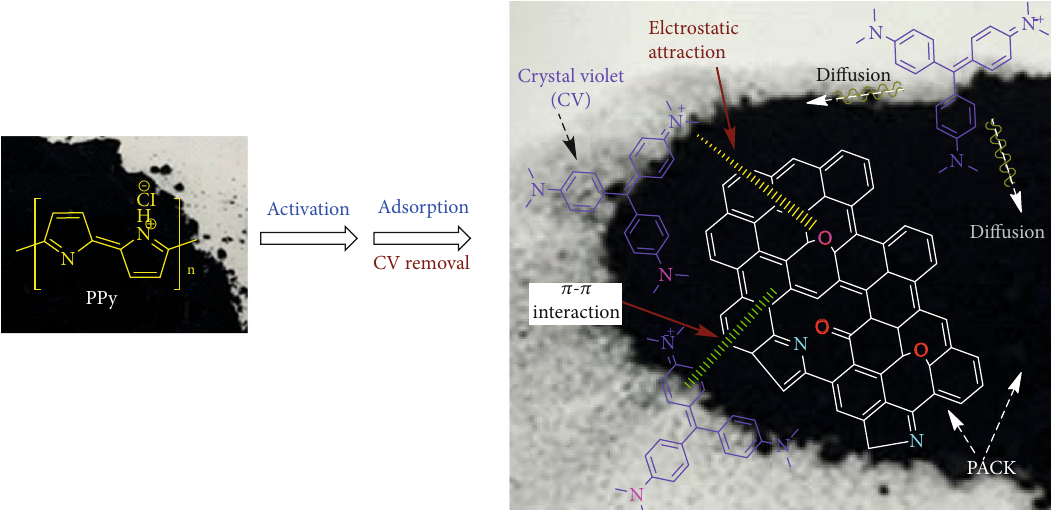
Figure 9: Schematic presentation of the adsorption mechanism of the cationic dye crystal violet by PACK adsorbent.